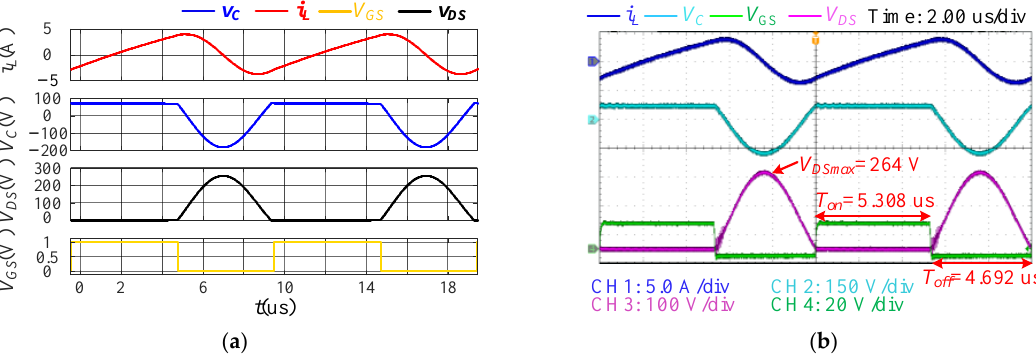
Figure 8. Simulation and experimentally obtained waveforms of single-ended resonant converter at P o = 25.495 W: ( a ) Simulated result; ( b ) experimental Result.